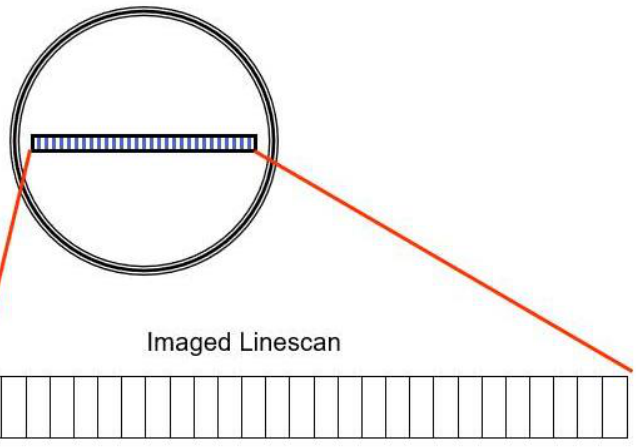
Figure 5. The array of SmartView camera, with a single row of pixels [30].